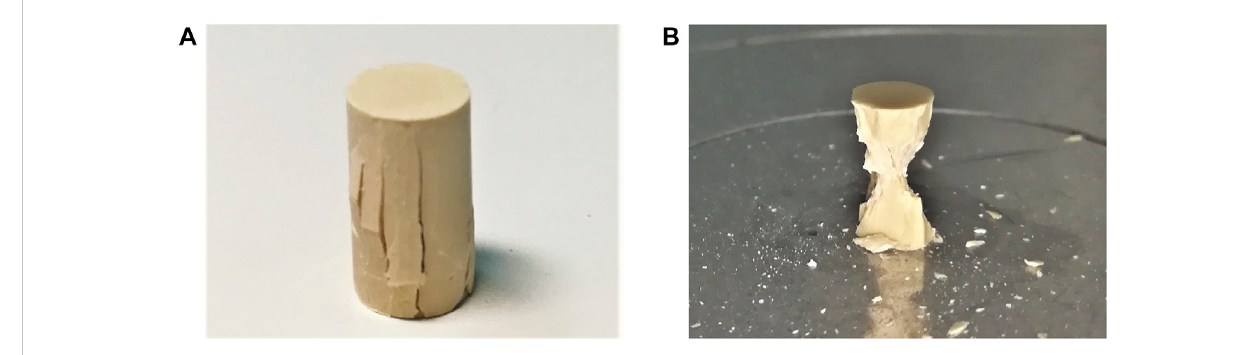
FIGURE 6 Photos of 5/10 specimens tested at material ages amounting to (A) 1 h, and (B) 7.5 h.